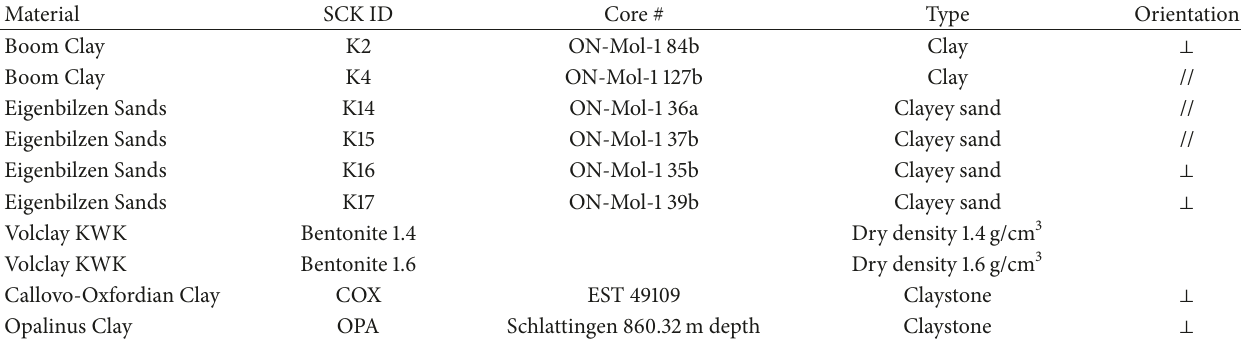
Table 1: Overview of used samples with the SCK ID, core number, type, and orientation with respect to the